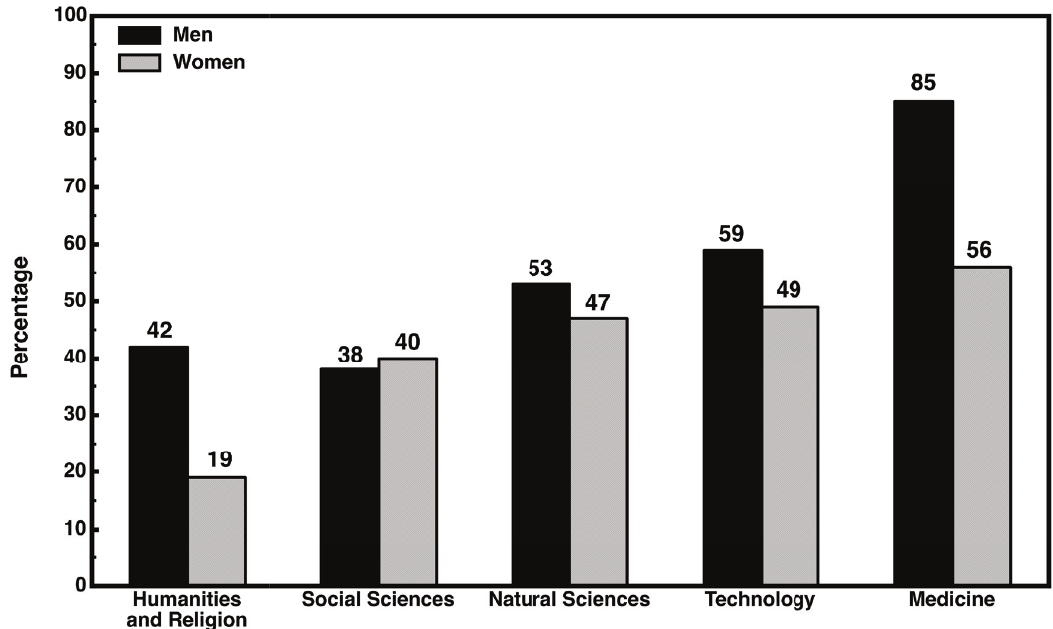
Figure 3. Academic exit rates (in percentages) for men versus women sorted by discipline, measured five years after completion of PhD. Data obtained from ref. 14, based on the 1993 cohort of doctoral